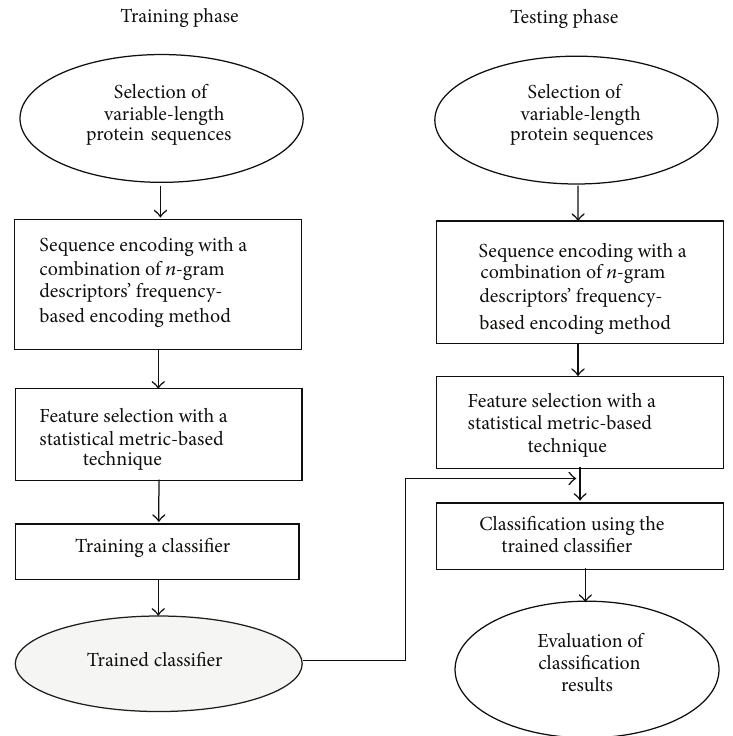
Figure 2: Phases of the proposed